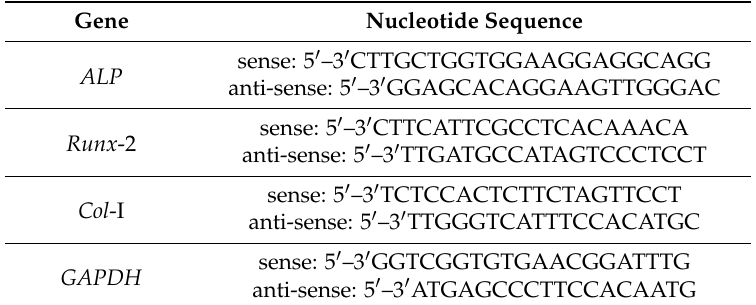
Table 1. Primer sequence used for